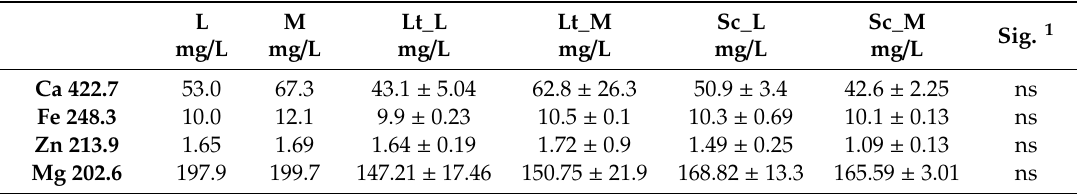
Table 6. The content of selected ions in wort brewed with Marynka (M) or Lubelski (L) hop pellets, and beer fermented by L. thermotolerans (Lt) or S. cerevisiae